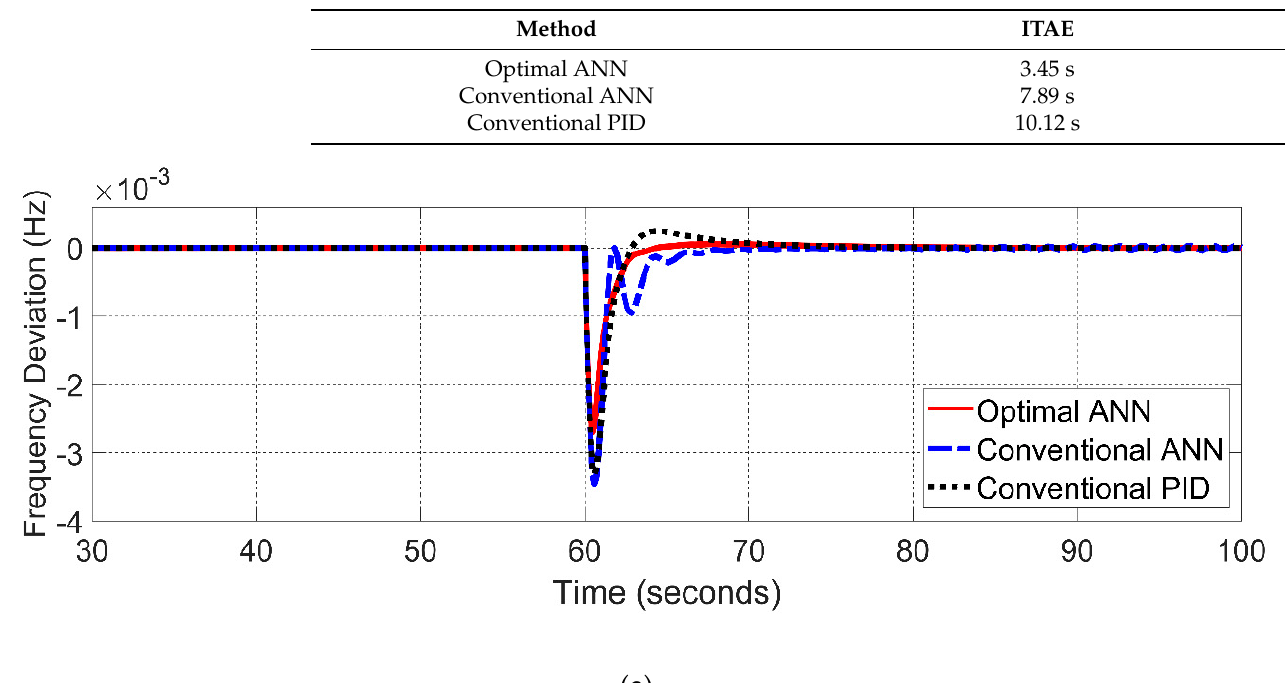
Figure 14. The active power mismatches between the supplied power and demanded power in the single-area.